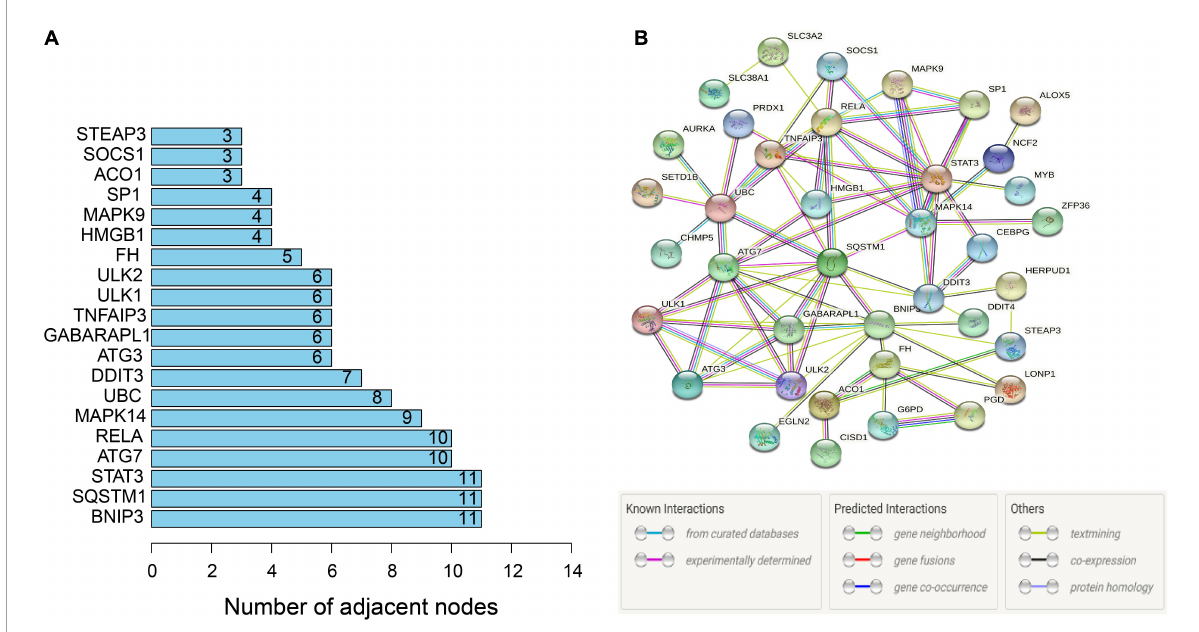
FIGURE5 PPI network. (A) PPI network of 46 ferroptosis-related genes. (B) Bar graph identifying the top 20 hub genes, ranked based on the number of nodes with which they are connected. PPI, protein-protein interaction.